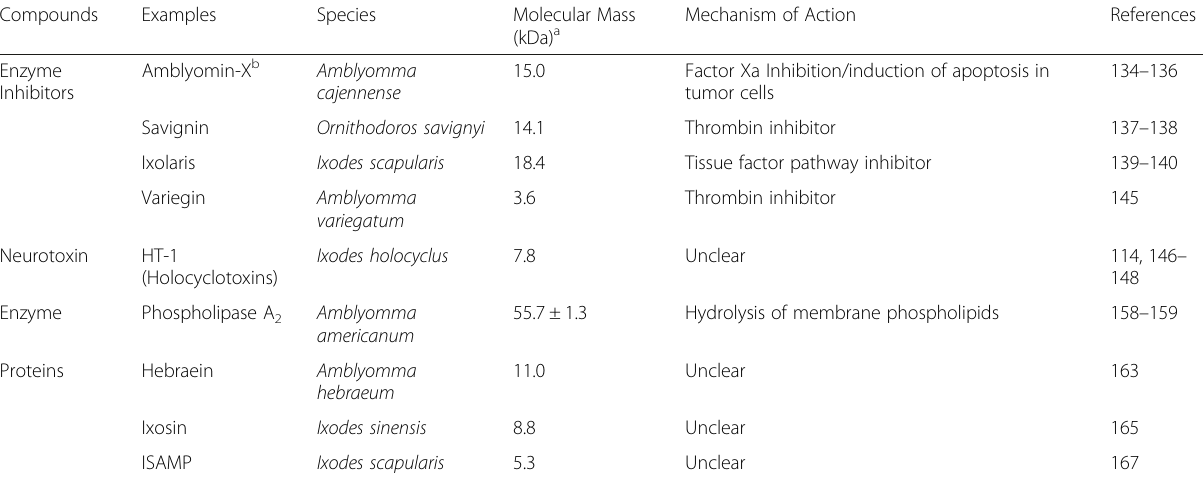
Table 3 Examples of compounds from tick saliva